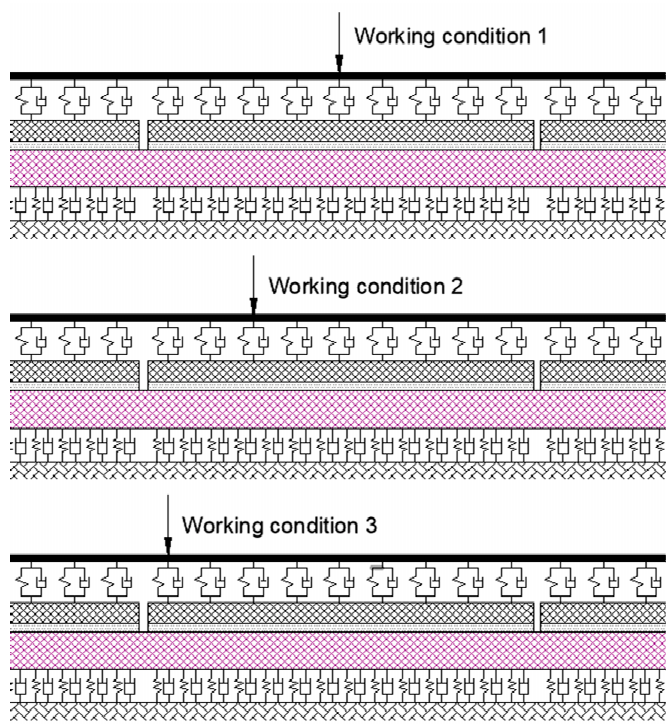
Figure 17. Three typical working conditions.